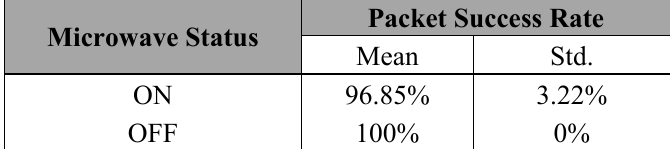
Table 5. Co-existence Test Results between IEEE 802.15.4 and Microwave